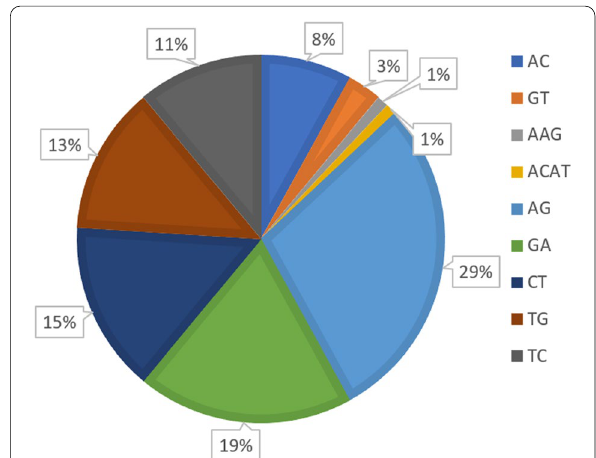
Fig. 4 Percentage of polymorphic SSRs per